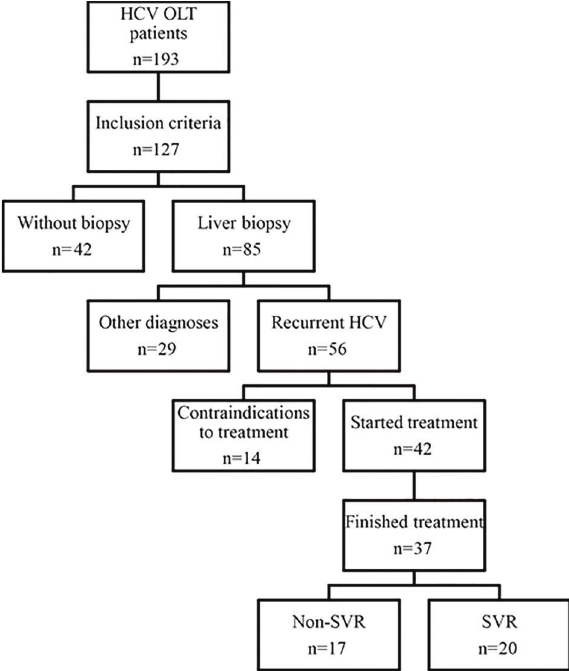
Figure 1. Algorithm of patient selection and treatment outcome. HCV: hepatitis C virus; OLT: orthotopic liver transplantation; SVR: sustained virological